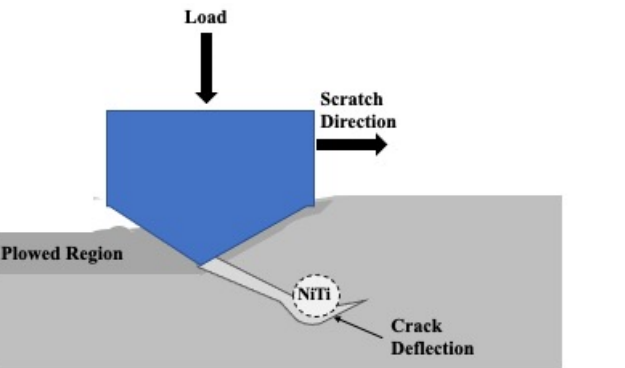
Figure 30. Representative Illustration of the Crack Deflection Mechanism During Sliding Wear.